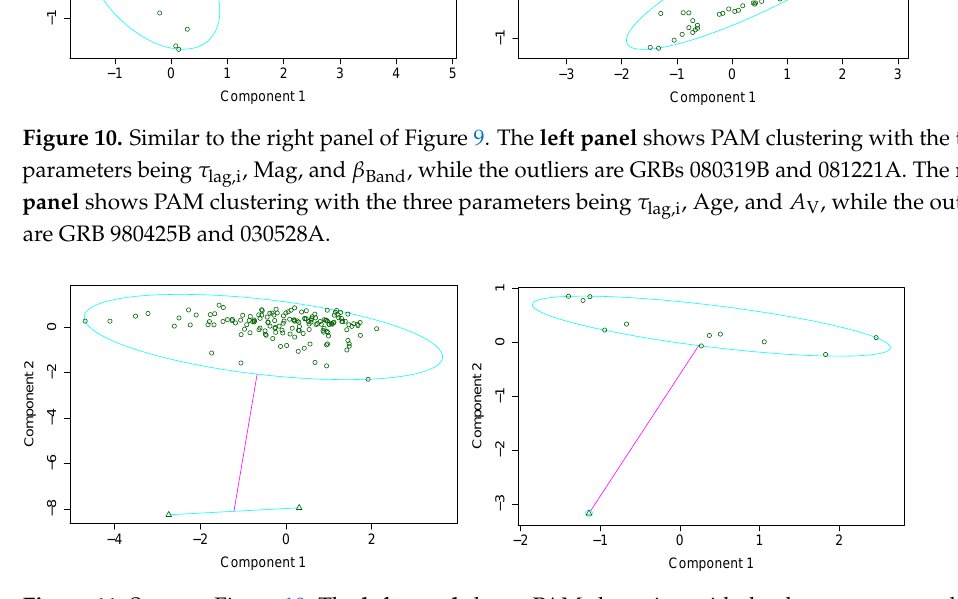
Figure 11. Same as Figure 10. The left panel shows PAM clustering with the three parameters being τ lag,i , T R45,i , and E iso,52 , while the outliers are GRB 980425B and 030528A. The right panel shows PAM clustering with the three parameters being τ lag,i , log t burst,i , and Age, while the outlier is GRB